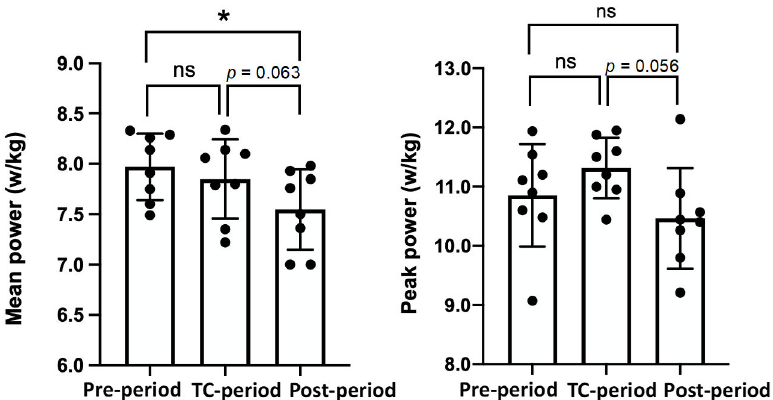
Figure 3. Mean and peak cycling power (w/kg) during a 40 s Wingate test in each period. The values are expressed as means ± SD. * p < 0.05 vs. the